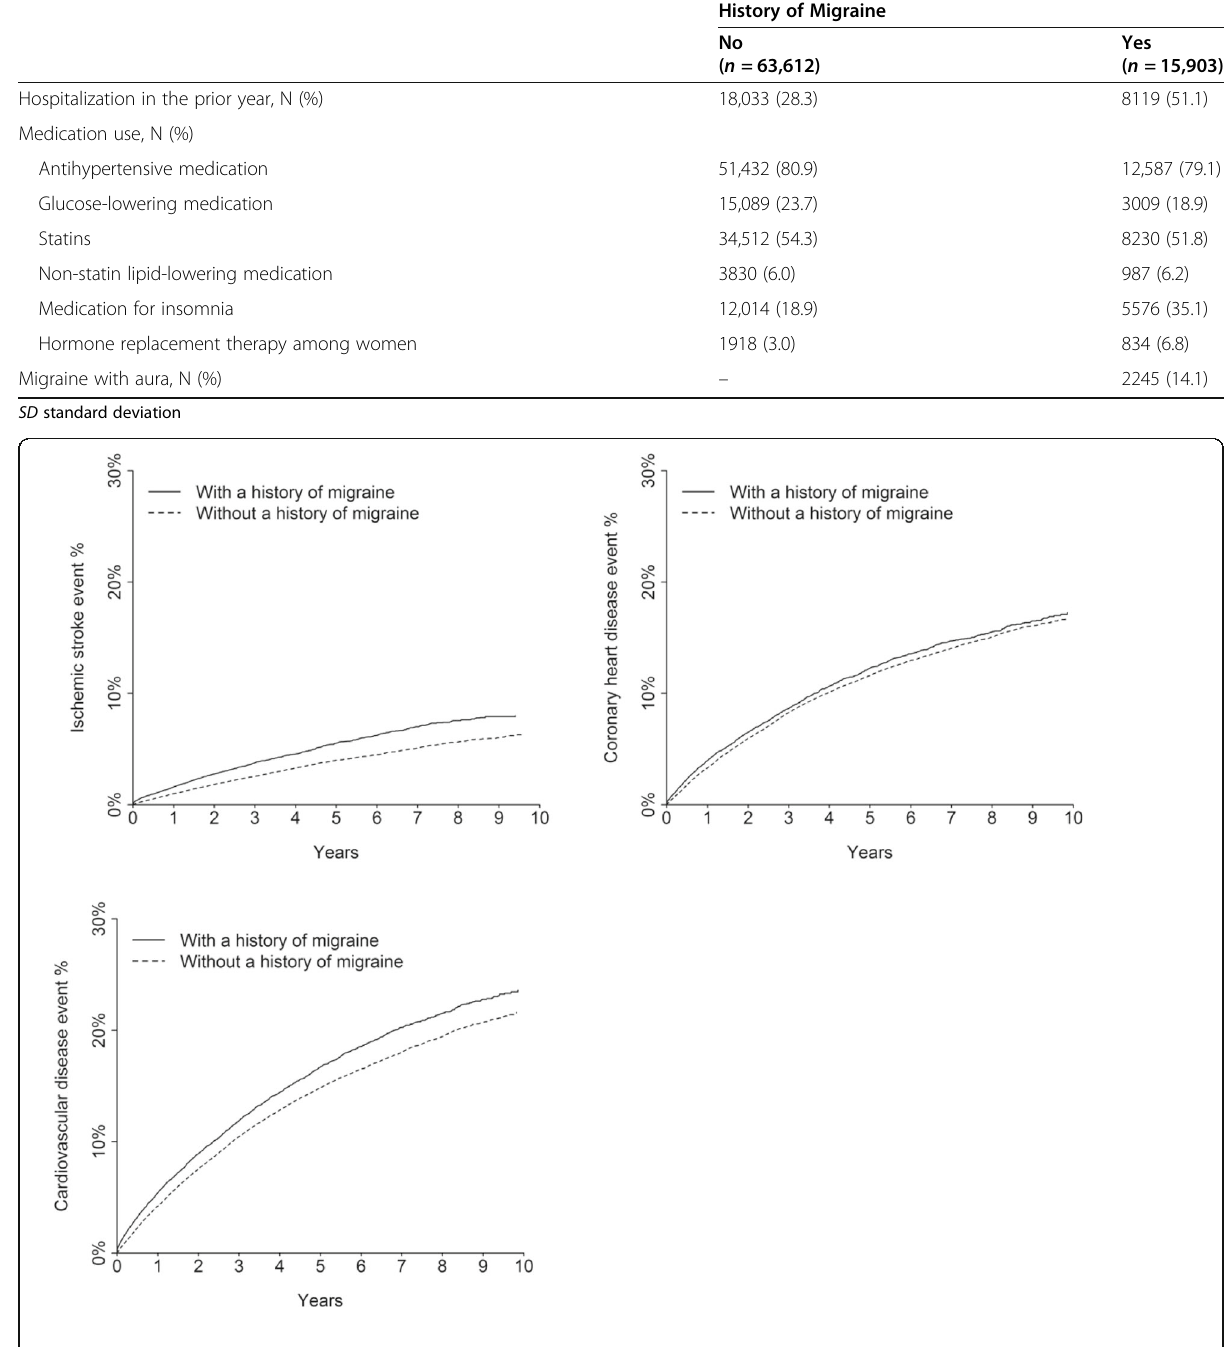
Fig. 3 Cumulative incidence of ischemic stroke, coronary heart disease and cardiovascular events among patients who had and did not have a history of migraine, restricted to those with a history of cardiovascular disease. CHD: coronary heart disease; CVD: cardiovascular disease. The cumulative incidence was calculated accounting for the competing risk of all-cause mortality using the method of Fine and Gray